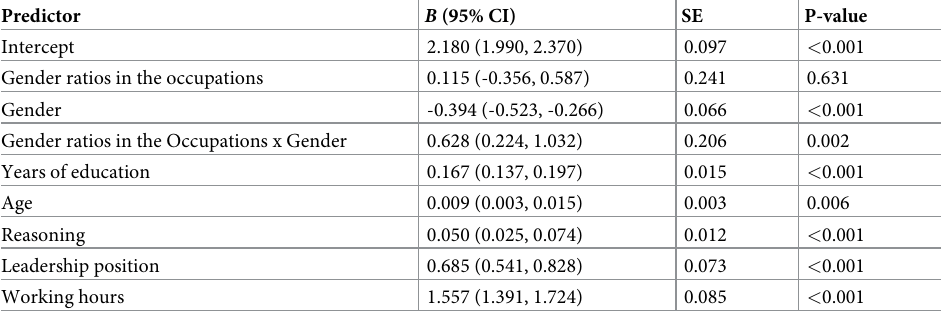
Table 3. Predictors of income: MRCM results for the interaction of gender and the gender ratios in the occupations. Predictor B (95% CI) SE P-value Intercept 2.180 (1.990, 2.370) 0.097 < 0.001 Gender ratios in the occupations 0.115 (-0.356, 0.587) 0.631 Gender -0.394 (-0.523, -0.266) 0.066 < 0.001 Gender ratios in the Occupations x Gender 0.628 (0.224, 1.032) 0.206 0.002 Years of education 0.167 (0.137, 0.197) 0.015 < 0.001 Age 0.009 (0.003, 0.015) 0.003 0.006 Reasoning 0.050 (0.025, 0.074) 0.012 < 0.001 Leadership position 0.685 (0.541, 0.828) 0.073 < 0.001 Working hours 1.557 (1.391, 1.724) 0.085 <